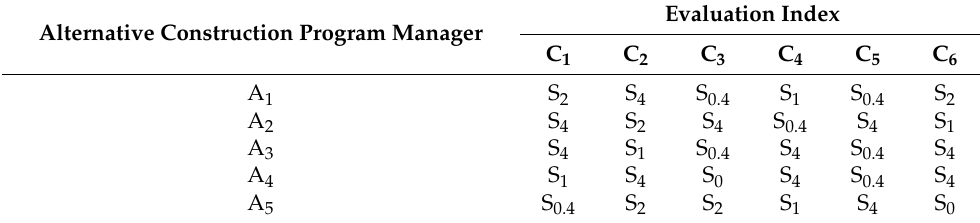
Table 4. Linguistic Multi-attribute Evaluation Matrix X 2 of decision maker D 2 .